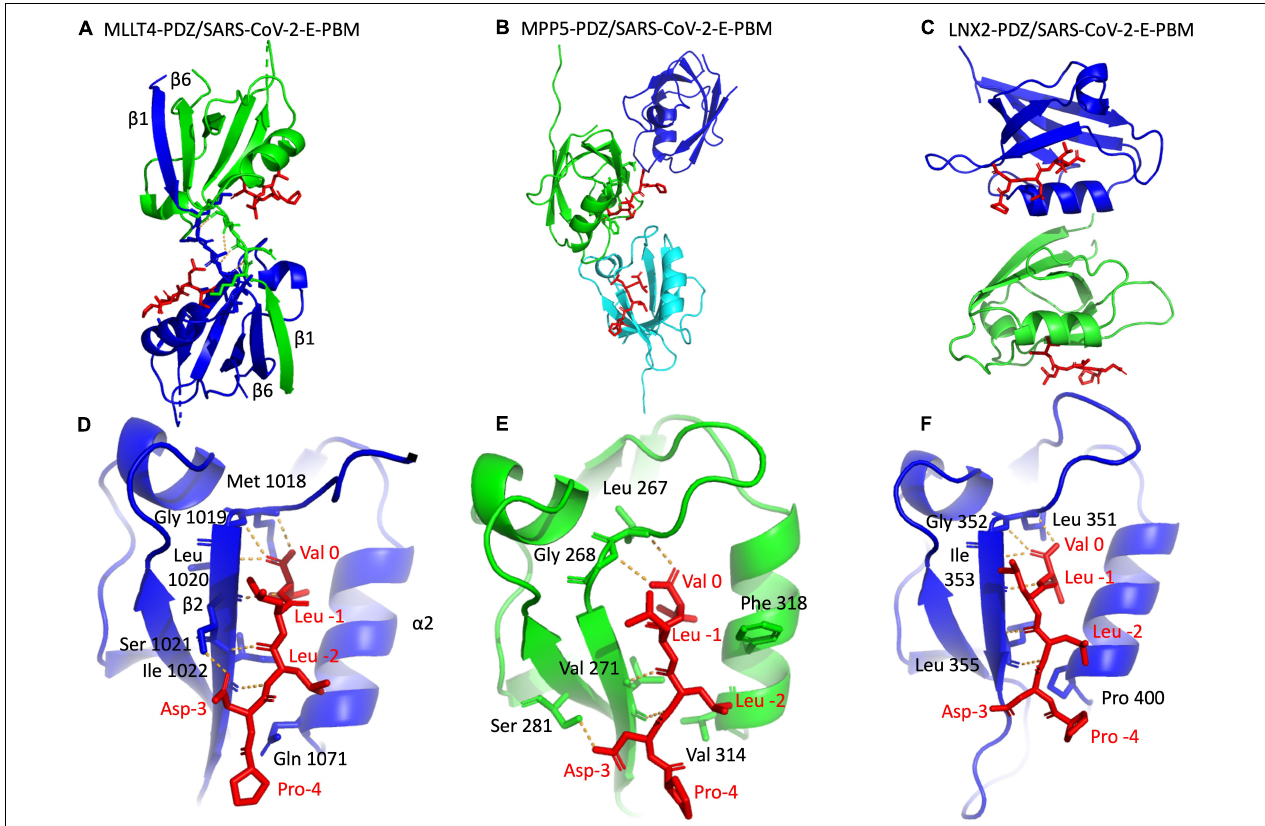
FIGURE 3 | X-ray structures of the PDZ domains of MLLT4, MPP5, and LNX2 bound to the SARS-CoV-2 protein E PBM. (A–C) The asymmetric unit of the PDZ domains of MLLT4, MPP5, and LNX2, respectively, bound to the SARS-CoV-2 protein E PBM shown as red sticks. (A) Selected interchain polar contacts related to the swapped dimer between the fragments Lys 1014–Gly 1017 of each chain are shown in orange, and the associated residues are shown as sticks. (D–F) Detailed views of the PDZ domains bound to SARS-CoV-2 protein E PBM. Important residues are labeled and shown as sticks. Intermolecular H-bonds and polar contacts are reported as orange dashed